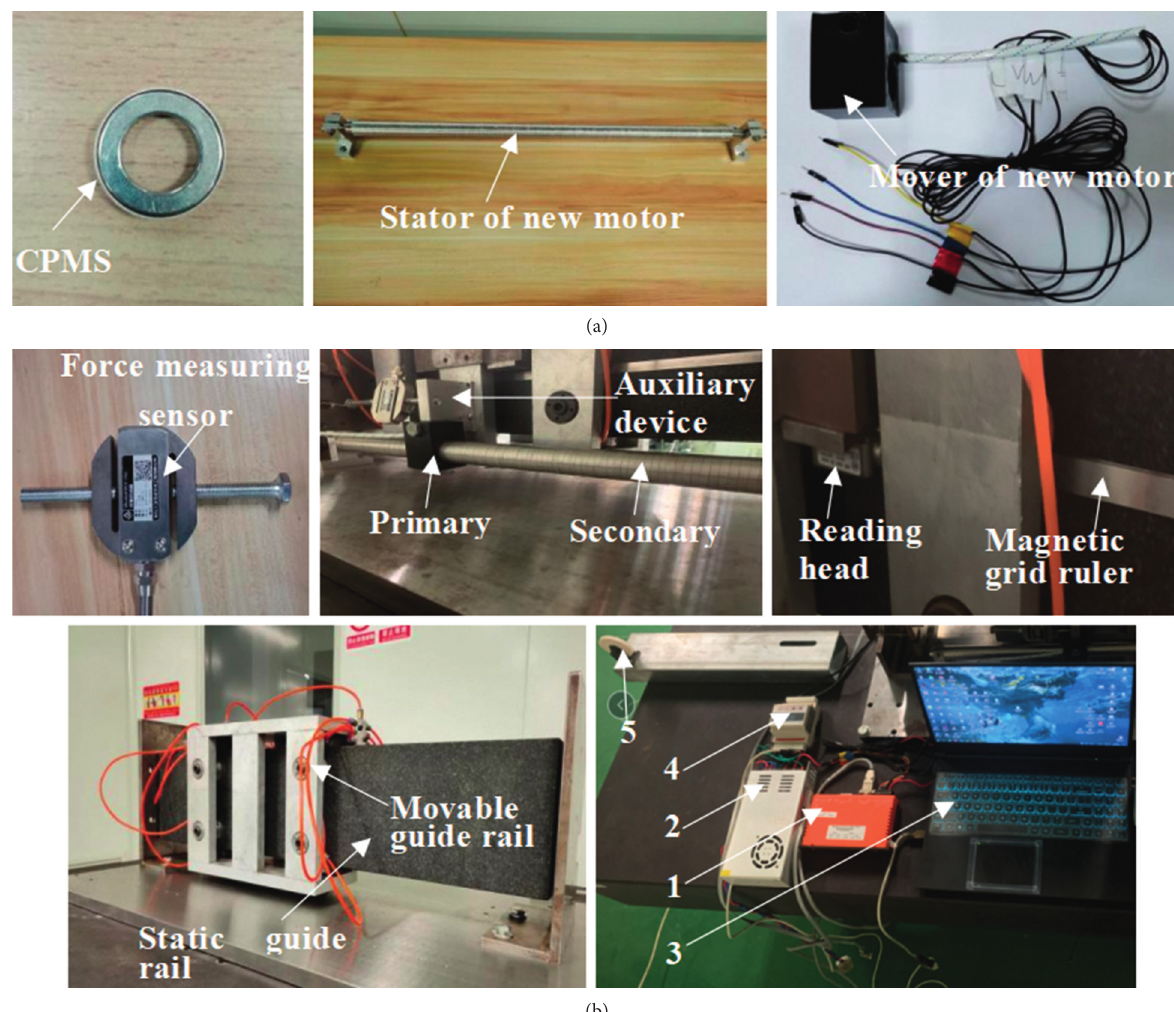
Figure 21: New motor and detection unit: (a) linear motor, primary and secondary; (b) data acquisition and control system ((1) DCPCA- 090-12-E, (2) 24V DC, (3) PC, (4) thrust display, and (5)